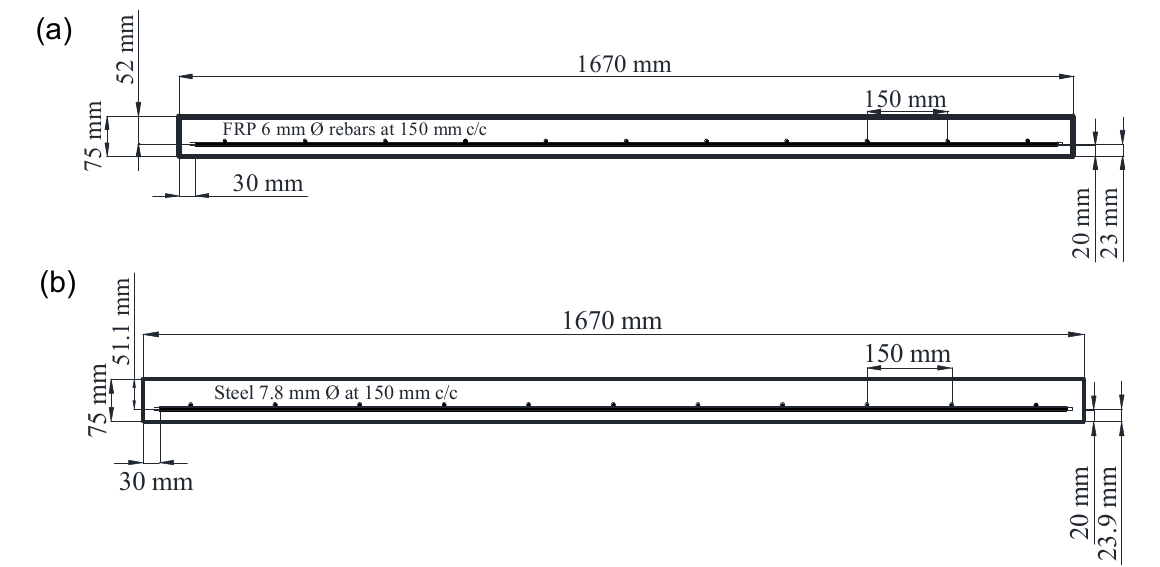
Figure 2. Cross-section (A–A) of ( a ) FRP reinforced slab and ( b ) steel reinforced slab.